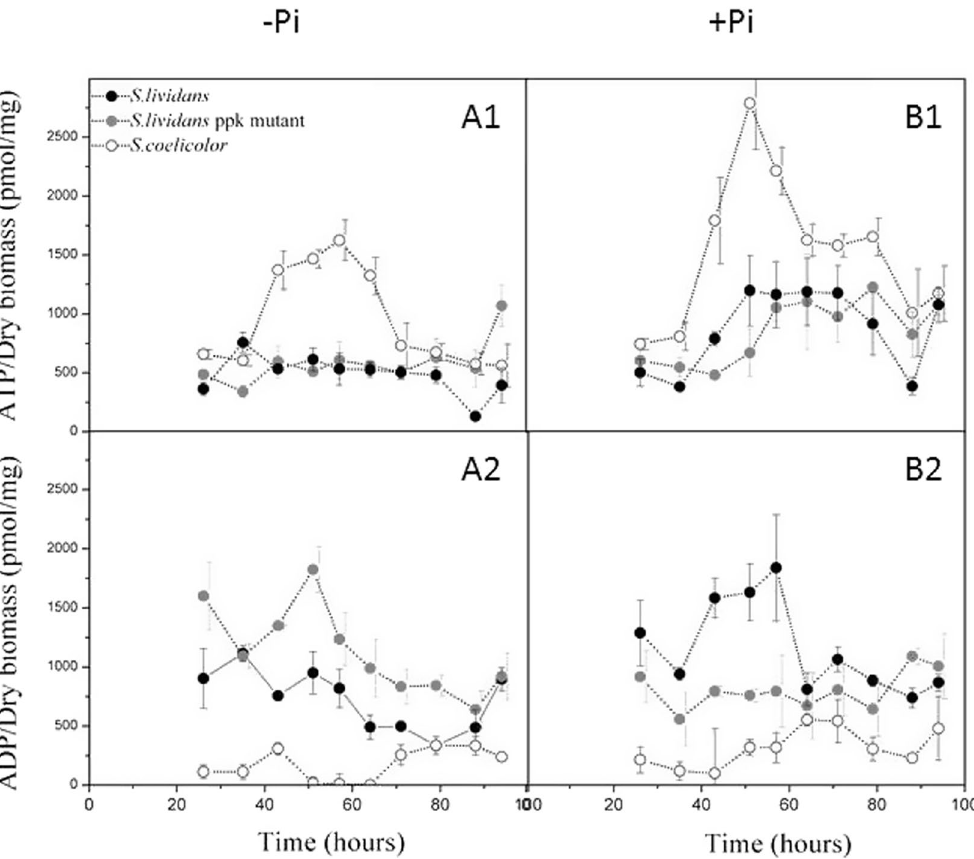
Figure 2. Quantification of intracellular ATP (A1,B1) and ADP (A2,B2) levels in S. lividans TK24 (black circles), its ppk mutant (grey circles) and S. coelicolor (open circles) grown in Pi limited ( A ) or Pi replete ( B ) conditions. The error bars represent the standard deviation of at least three independent